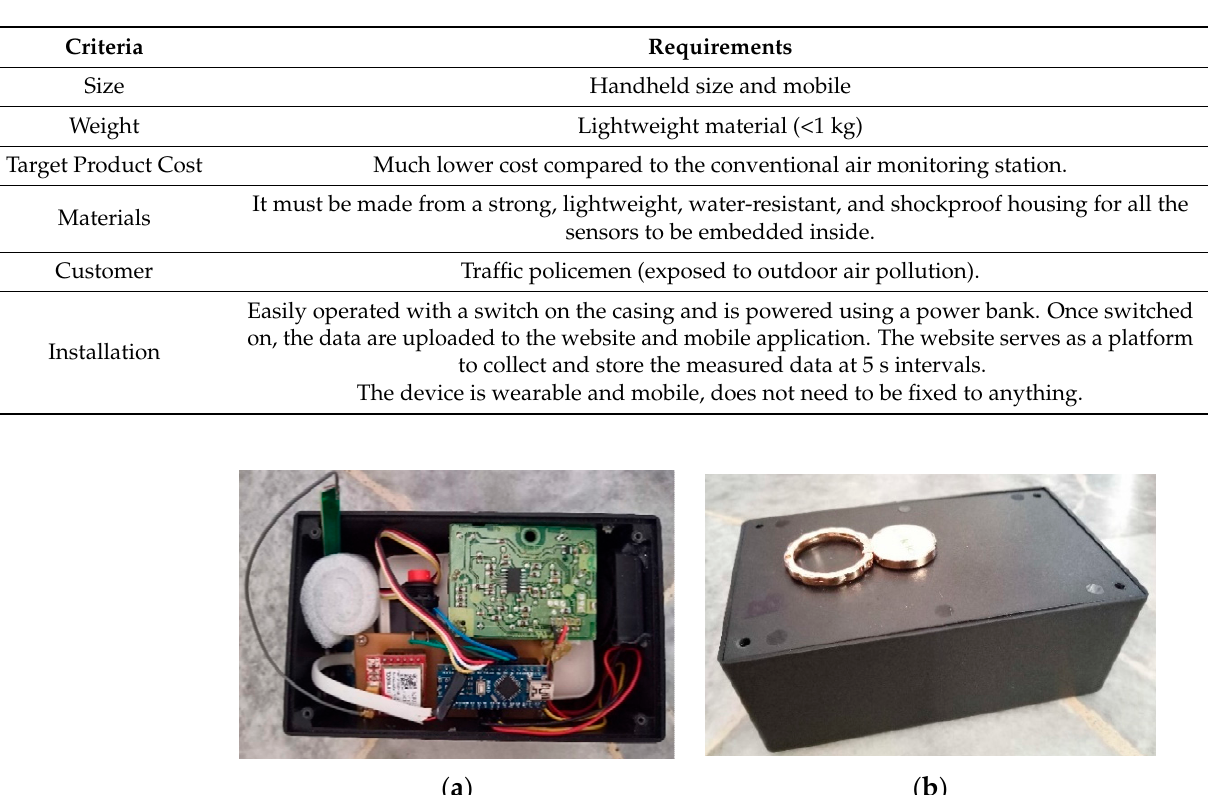
Figure 5. Prototype ( a ) Internal Connection. ( b ) External case.